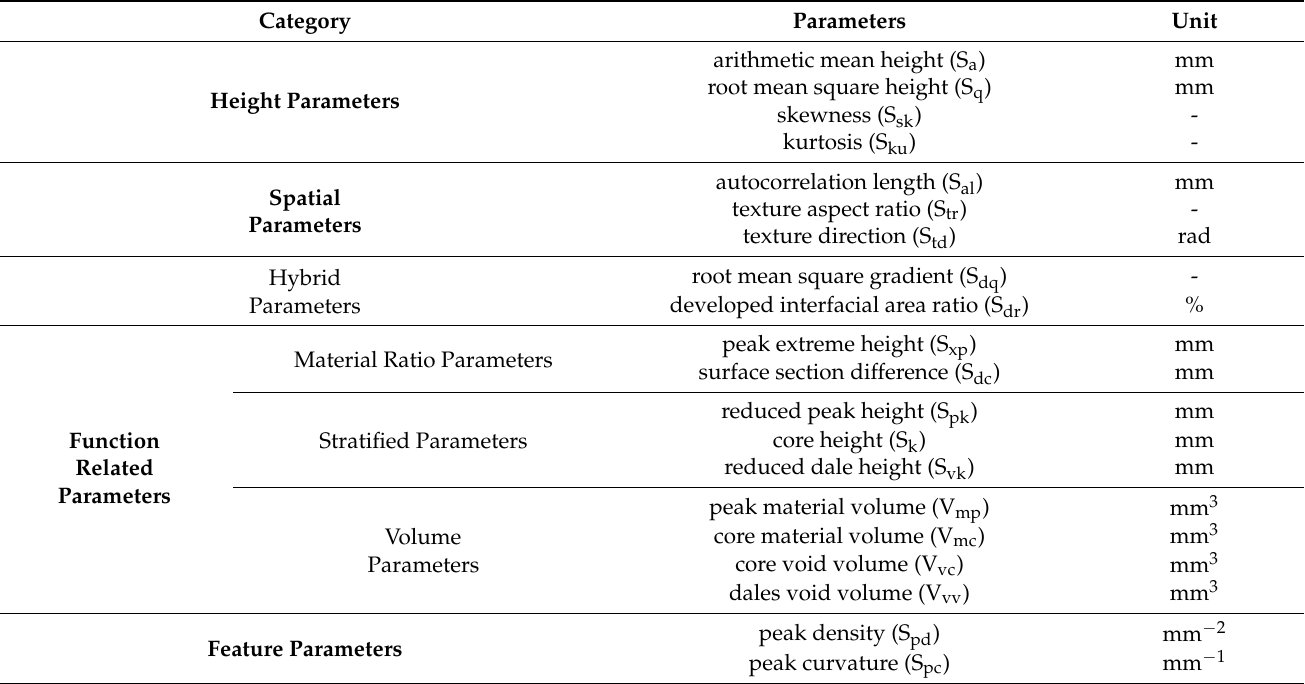
Table 1. Summary of 3D areal